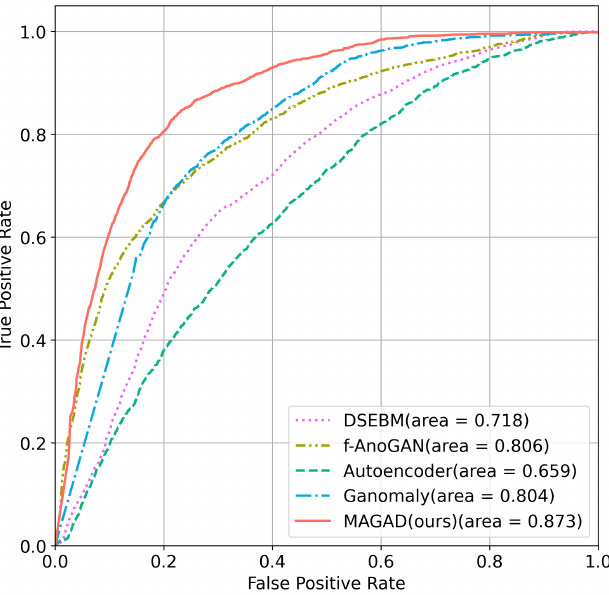
Figure 9. Comparison of ROC curves among five